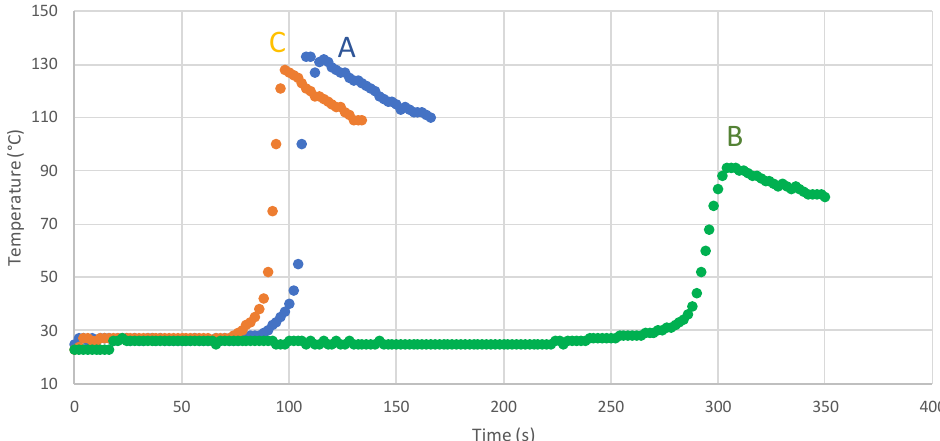
Figure 6. Optical pyrometric measurements (temperature vs. time after mixing; 4 mm thick sample) under air for the BM resin for Redox FRP using a T4epa/Iod (1.5%/1% w/w ) RIS in presence of different inhibitors: ( A ) without inhibitor; ( B ) 4-Hydroxy-TEMPO (0.05% w/w ); ( C ) 4-methoxyphenol (0.05% w/w ).